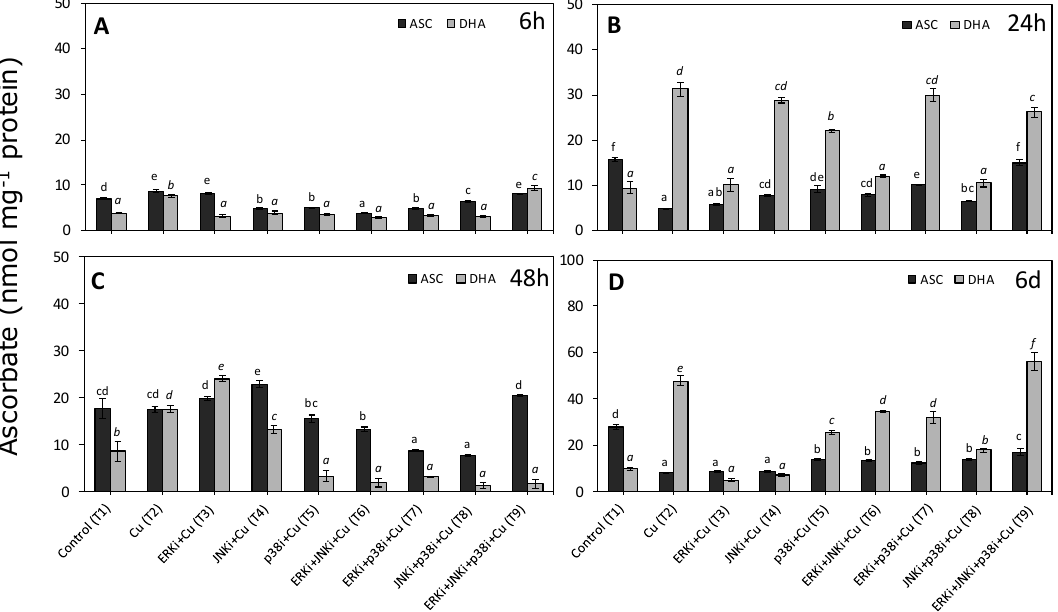
Figure 4. Total reduced ascorbate (ASC) and dehydroascorbate (DHA) concentrations in U. compressa under copper and/or exposure to MAPK inhibitors. Treatments consisted in: T1) control only with seawater; T2) solely copper exposure as 10 µM of CuSO 4 (Cu); T3) copper + 5 µM MAPK ERK inhibitor PD98059 (Cu + ERKi); T4) copper + 5 µM MAPK JNK inhibitor SP600125 (Cu + JNKi); T5) copper +